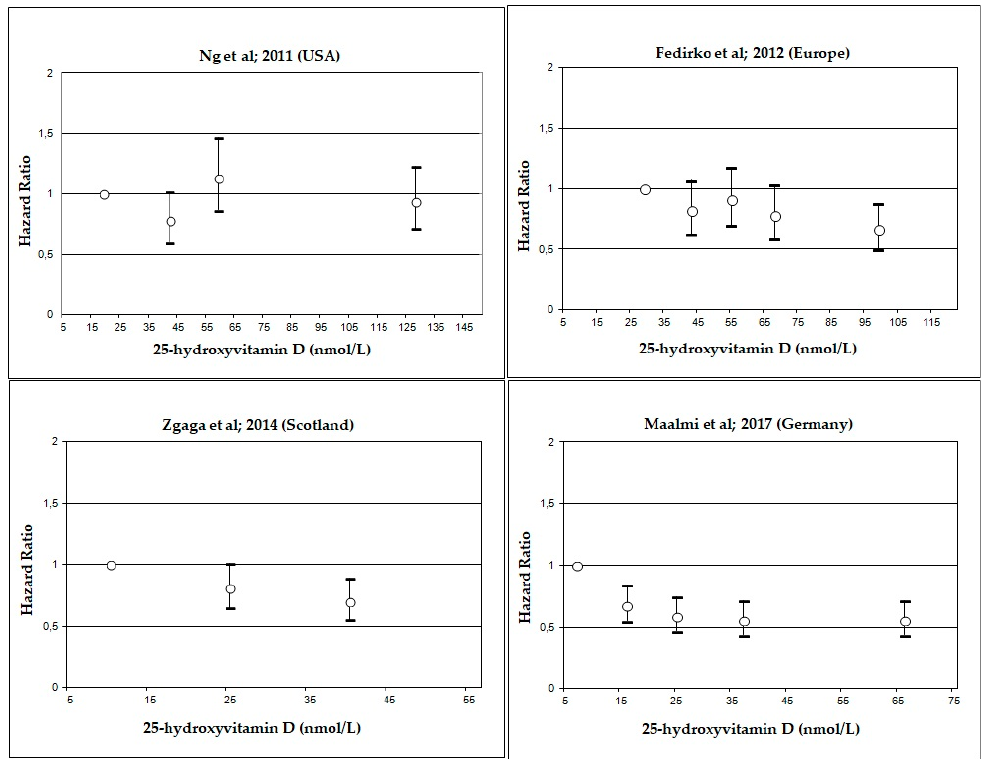
Figure 4. Hazards ratios and 95% confidence intervals for overall survival in colorectal cancer (CRC) patients according to circulating 25-hydroxyvitamin D (25(OH)D) serum concentrations. Depending on available information, medians, mid-points or means of the categories were used for the definition of study specific concentrations of serum 25(OH)D categories.